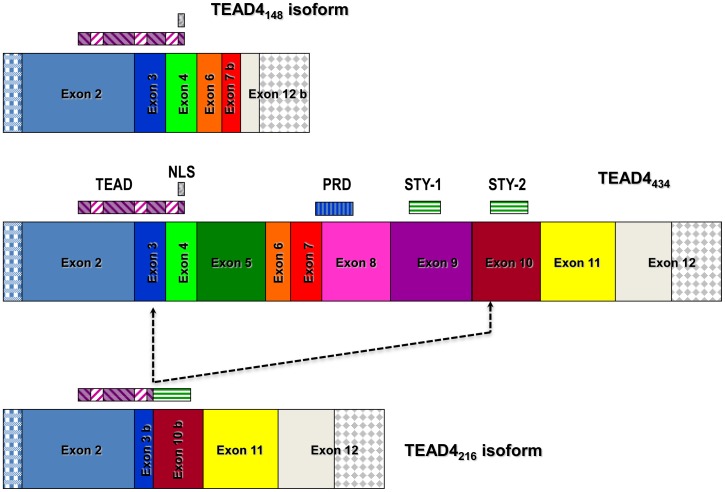
Schematic diagram of the full length TEAD4 (TEAD4434) and the novel TEAD4216 isoform.The previously identified TEAD4148 isoform is also shown for comparison. Schematic indicates the TEA DNA-binding domain (TEAD), a putative nuclear localization signal (NLS), a proline rich domain (PRD) and serine-threonine-tyrosine (STY) domains.